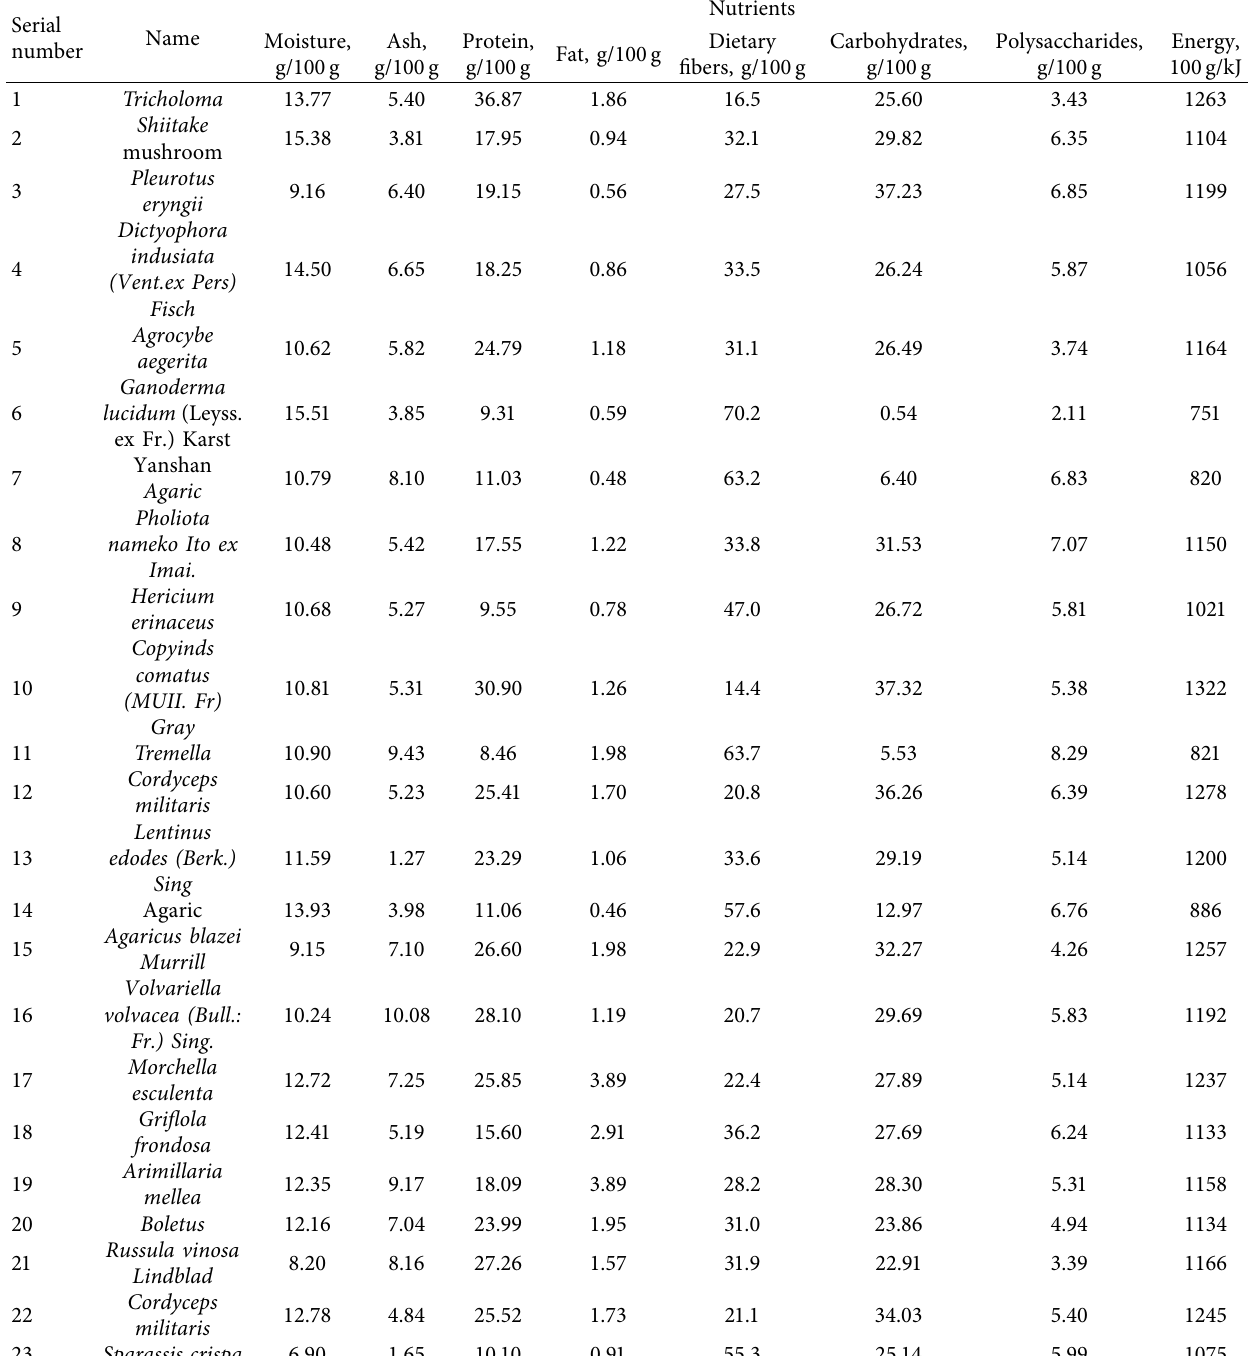
Table 1: Determination results of nutrient content of 23 kinds of edible